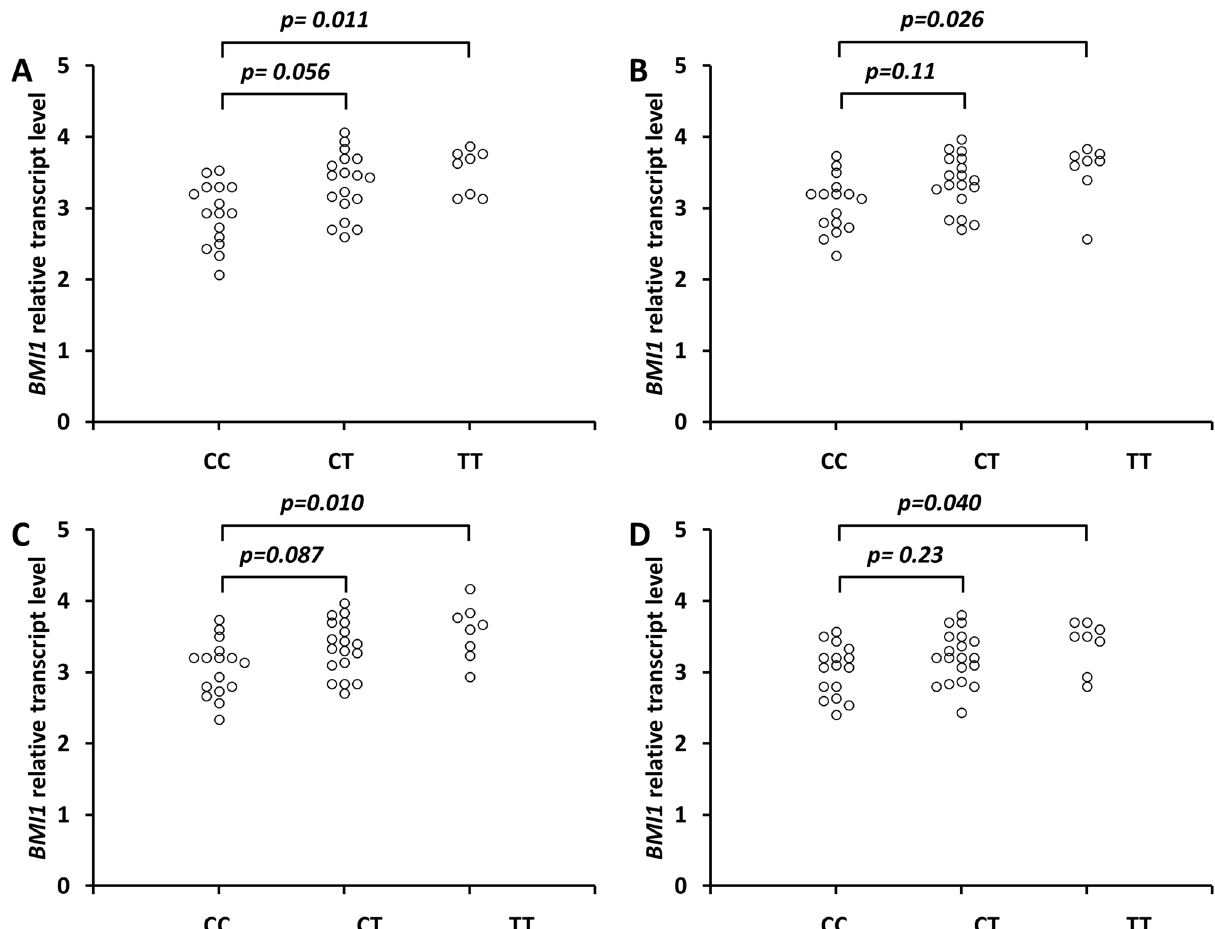
Figure 1. Effect of the CCAT1 rs67085638 SNP on BMI1 transcript levels in primary GC tissue samples classified as grade G3 ( A ) and those classified as N3 lymph nodes ( C ) and distal counterpart surgical resection margins histopathologically confirmed disease-free for grade G3 ( B ) and N3 lymph nodes ( D ). Frozen tissue was homogenized, followed by total RNA isolation. Quantitative analyses of BMI1 transcript levels were performed by qRT-PCR using the SYBR Green I system (Supplementary Table 2). The quantity of BMI1 transcript levels in each sample was standardized by the geometric mean of references using HMBS and B2M cDNA levels. Kruskal–Wallis test with a Dunn’s post hoc test (Supplementary Table